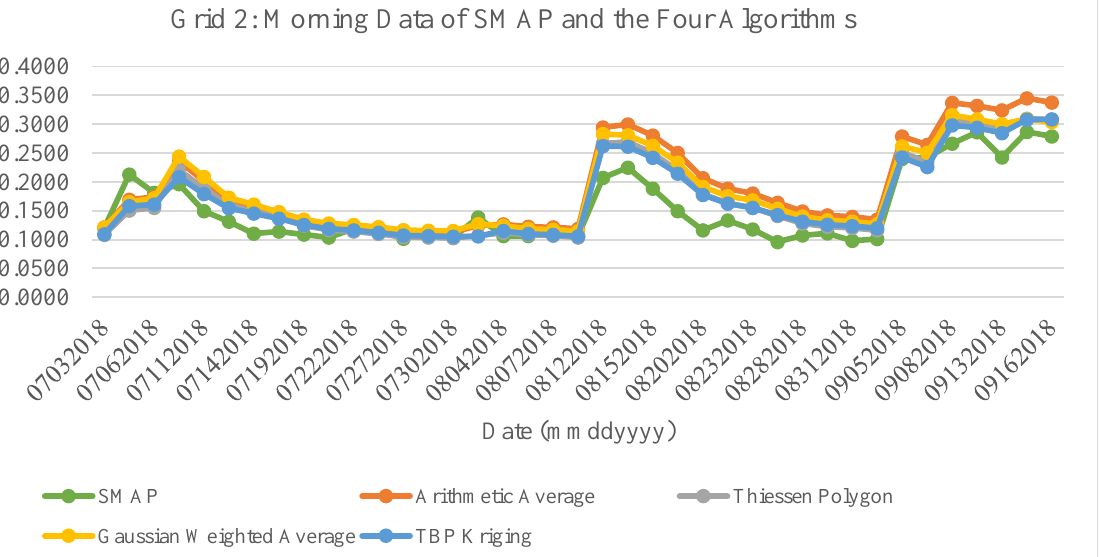
Figure 6. Grid 2 — spatial autocorrelation detected: morning soil moisture data plot with SMAP and the four algorithms. Soil moisture was measured at 5 cm depth. Orange line: time plot of SMAP and arithmetic average for the morning data for the TxSON stations from June to September 2018. Gray line: time plot of SMAP and Thiessen polygon method for the morning data for the TxSON stations from June to September 2018. Yellow line: time plot of SMAP and Gaussian-weighted average for the morning data for the TxSON stations from June to September 2018. Blue line: time plot of SMAP and TBP kriging for the morning data for the TxSON stations from June to September 2018.